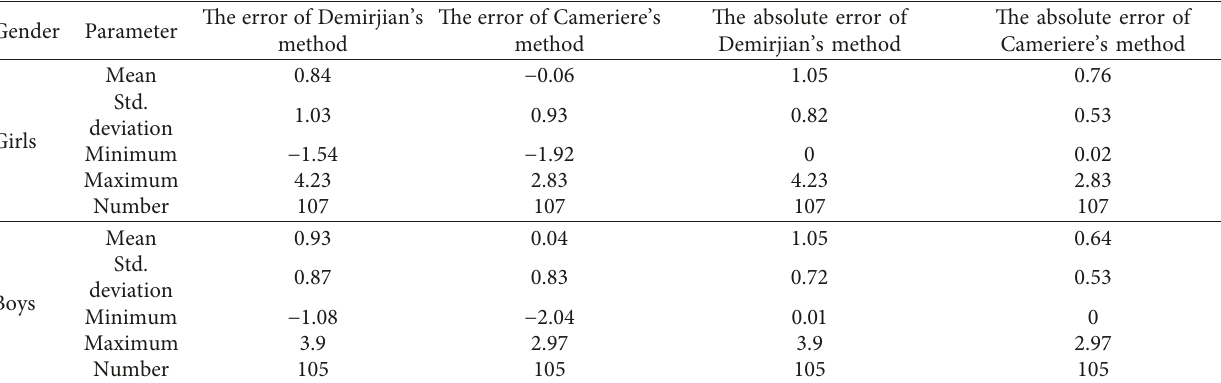
Table 2: Measures of central dispersion for the mean error of the two age estimation methods in girls and boys. The error of Demirjian’s The error of Gender Parameter method